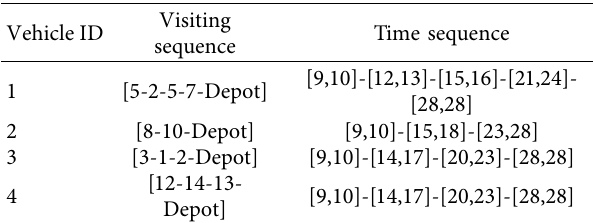
Table 9: Optimal solution demonstration when τ � 9.